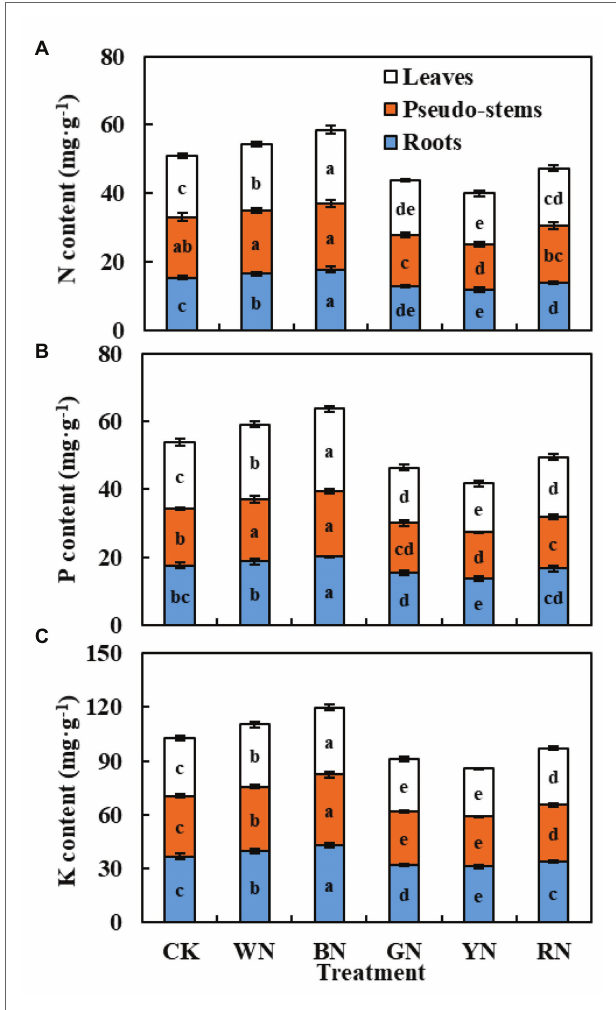
FIGURE 8 | The effect of photo-selective nets on element content of green onion leaves, pseudo-stems, and roots during the harvest stage. (A) N content, (B) P content, (C) K content. CK, control; WN, white photo-selective nets; BN, blue; GN, green; YN, yellow; and RN, red. Values are average ± SD, n = 18. Error bars indicate standard errors. Different letters (a, b, c, d, and e) in the same column indicate significant differences among treatments at p ≤ 0.05 according to Duncan’s new multiple range